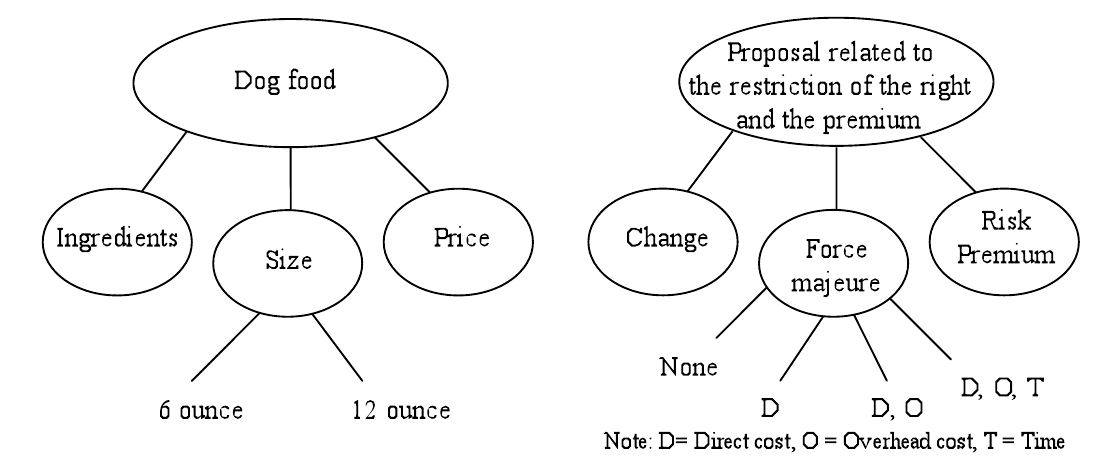
Figure 1: The attributes and the characteristics of an attribute of a dog food versus those of a proposal related to the restriction of the right to claim for compensation and the